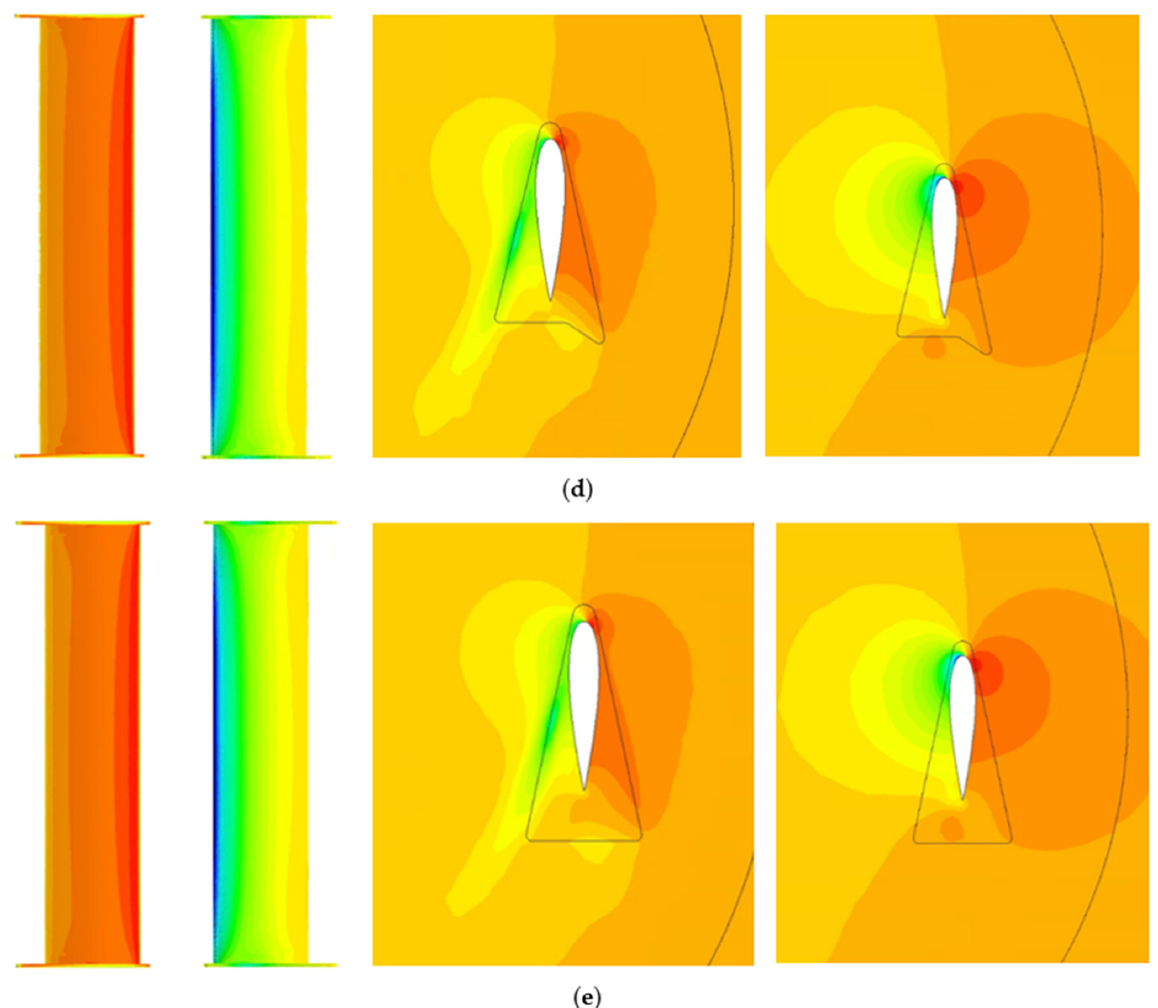
Figure 15. From left to right is the pressure distribution at the pressure side, suction side, at 0.015625 H and 0.5 H of Blade 1 at θ = 90° and TSR 2 for ( a ) baseline, ( b ) offset, ( c ) symmetric V, ( d ) asymmetric and ( e ) triangular endplates.